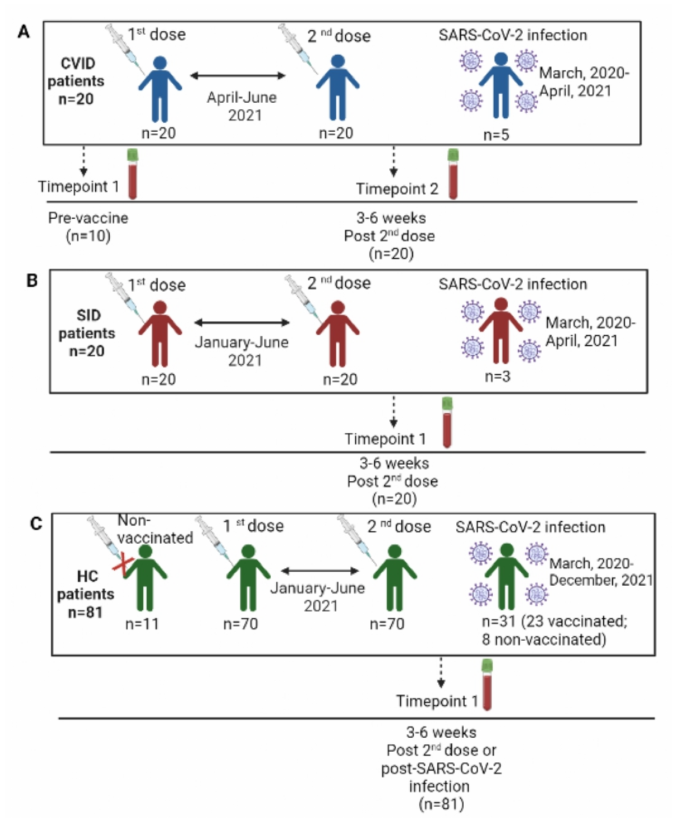
Figure 1. Schedule of vaccination and SARS-CoV-2 infection of our study population. ( A ) CVID patients. ( B ) SID patients. ( C ) HC